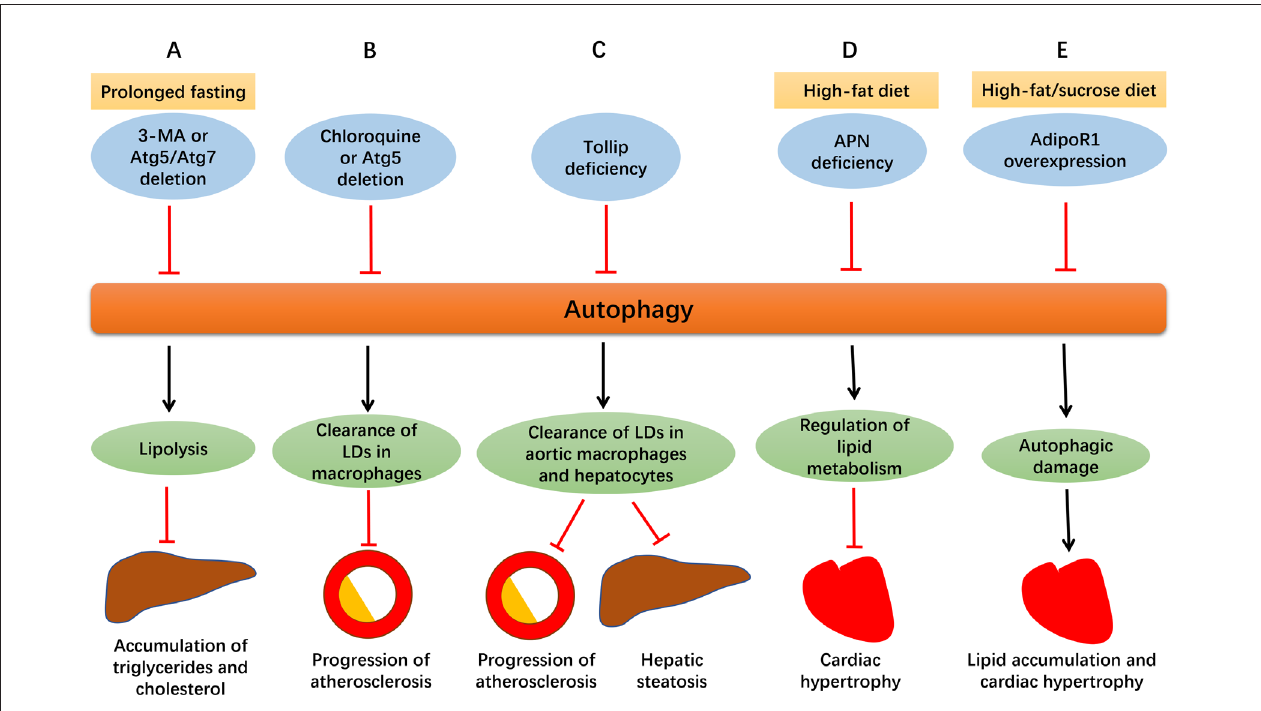
FiguRe 2 | Defective autophagy alters lipid homeostasis. (A) In prolonged fasting, suppressed autophagy by 3-MA or genetically ablation of Atg5 or Atg7 promotes delivery of fatty acids to the liver with suppressed hepatic lipolysis at the same time, resulting in the accumulation of triglycerides and cholesterol in the liver. (b) Suppressed autophagy by chloroquine or Atg5 deletion in macrophages disrupts cholesterol efflux, leading to excessive lipid droplets (LDs) deposition and ultimately, enlargement of atherosclerotic plaques. (C) Tollip deficiency impairs lipophagy and contributes to lipid accumulation in aortic macrophages and hepatocytes, which aggravates atherosclerosis and hepatic steatosis. (d) Adiponectin (APN) deficiency disturbs autophagy and leads to accentuation of obesity and cardiac hypertrophy in high-fat diet intake. (e) In the face of prolonged high-fat/sucrose diet intake, AdipoR1 overexpression disrupts excessive autophagy, alleviates lipid accumulation and lipotoxicity, and retards cardiac